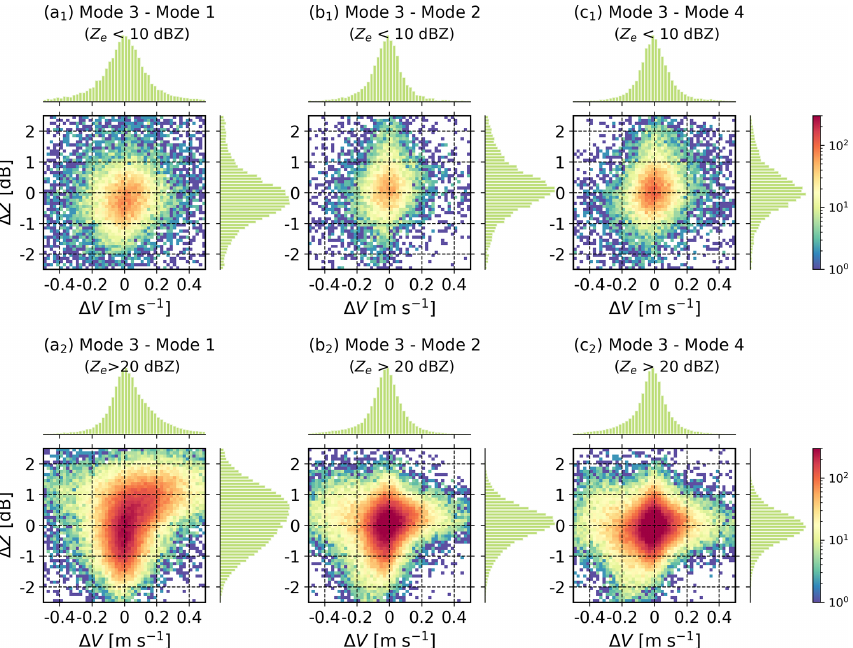
Figure 9. Statistics of (cid:49)Z and (cid:49)V for the Ku-band radar. (a1–c1) Precipitation cases with Z e < 10dBZ; (a2–c2) precipitation cases with Z e > 20dBZ.